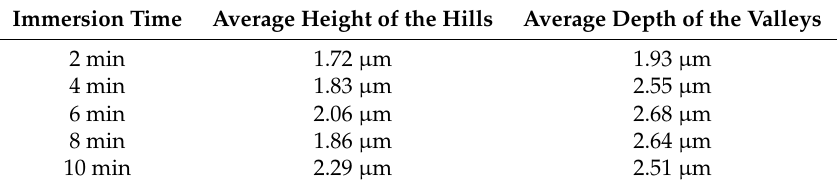
Table 3. The average height and depth of microlevel structures. The nano-structures with height less than 1 µ m are not considered in the